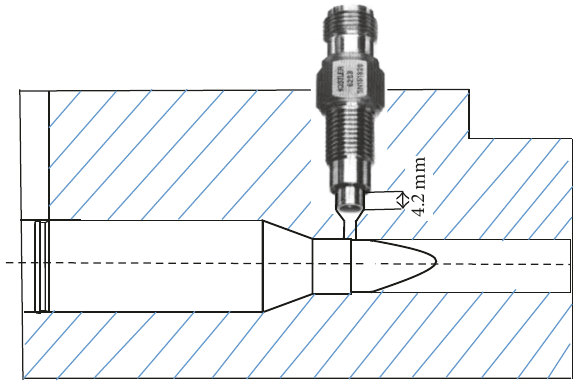
Figure 6: Piezo sensor for cartridge case mouth